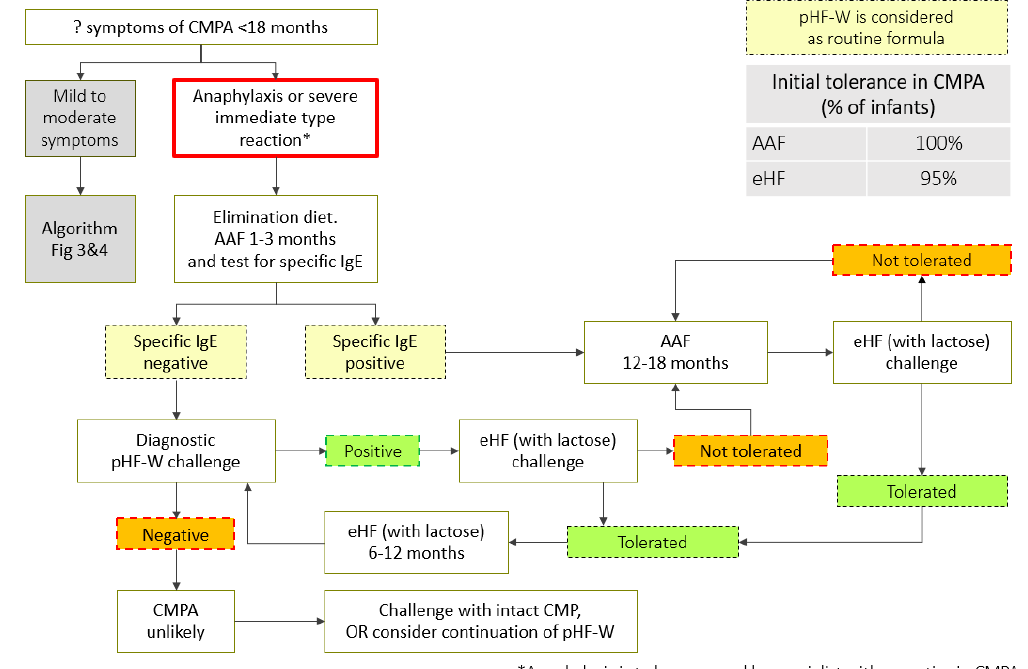
Figure 2. CMPA step-down treatment algorithm (anaphylaxis). AAF: amino acid based formula; Figure 2